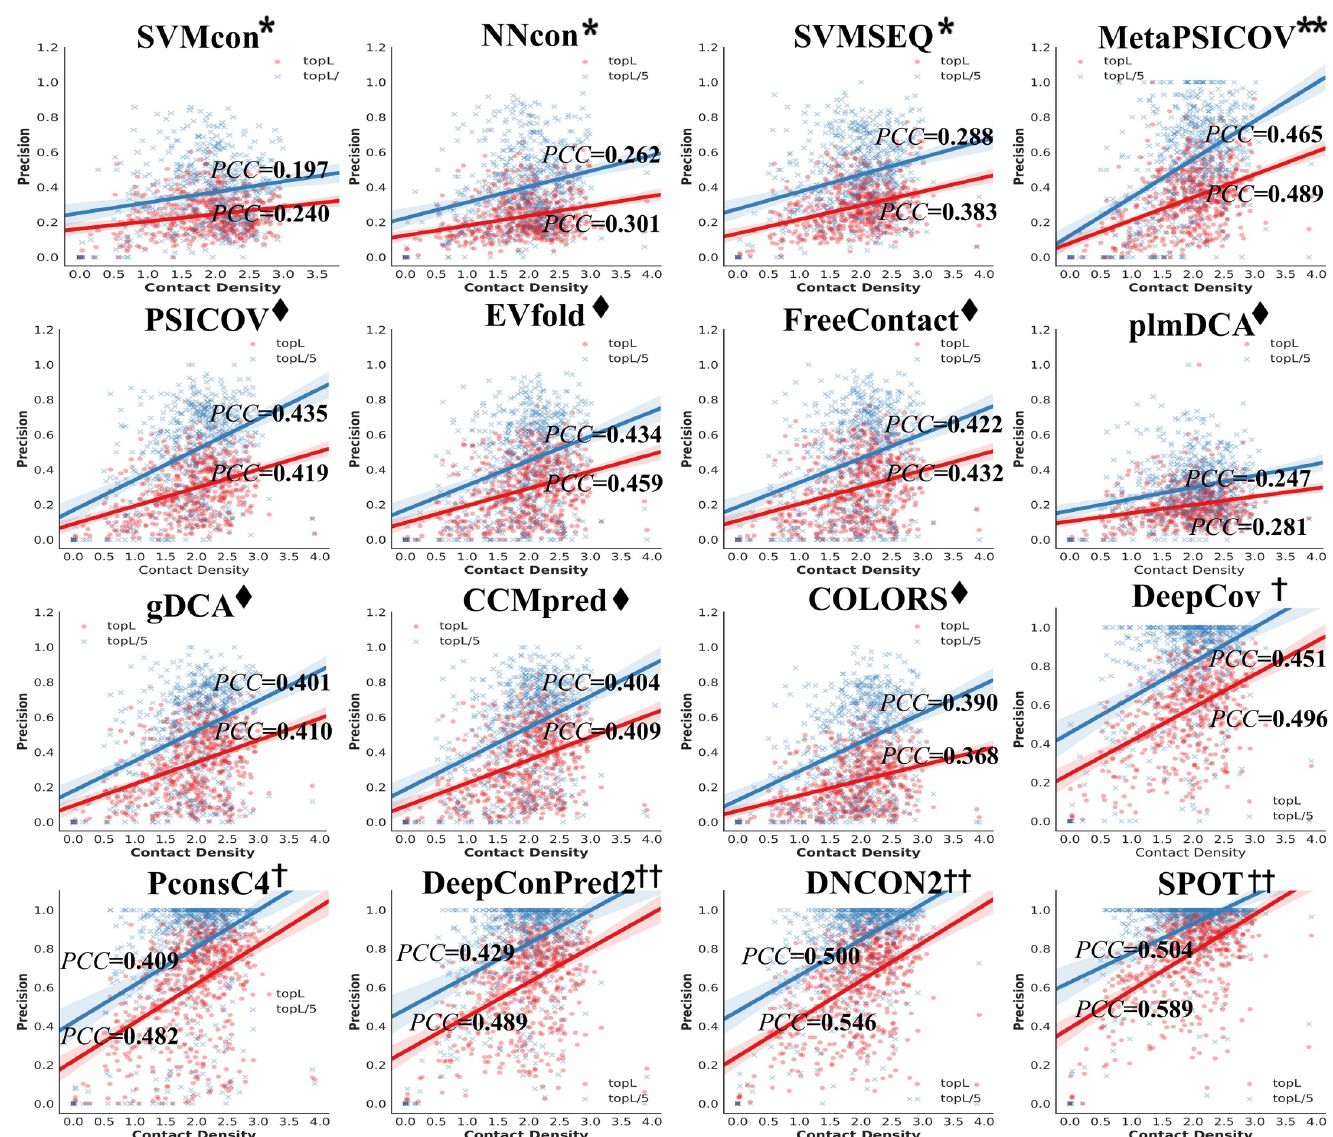
Fig 5. The plot of precisions for all-range contacts versus contact density on TestSet1. Red dots and blue crosses indicate the targets for top L and top L/5 predictions, respectively. Pearson’s correlation coefficient (PCC) is used to measure the linear correlation between prediction precision and contact density. All methods show correlations between precision and contact